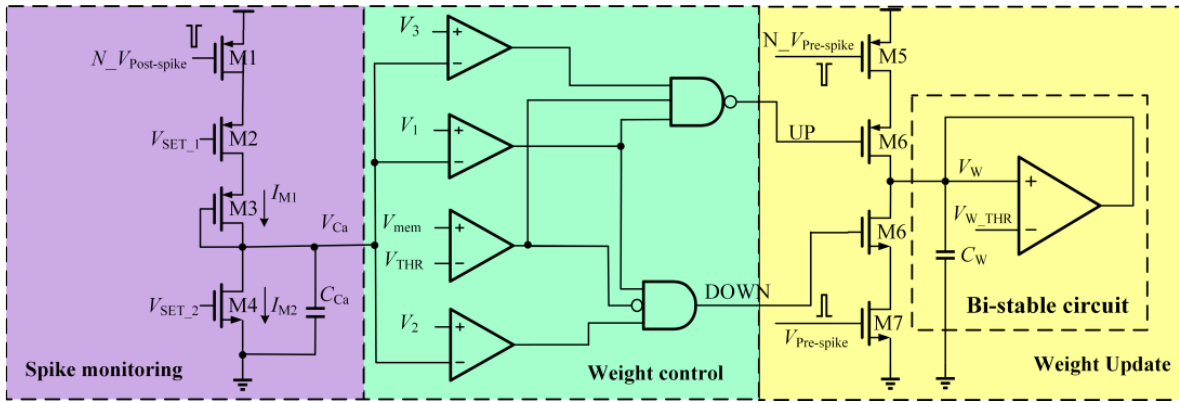
Figure 3. SDSP learning algorithm circuits.